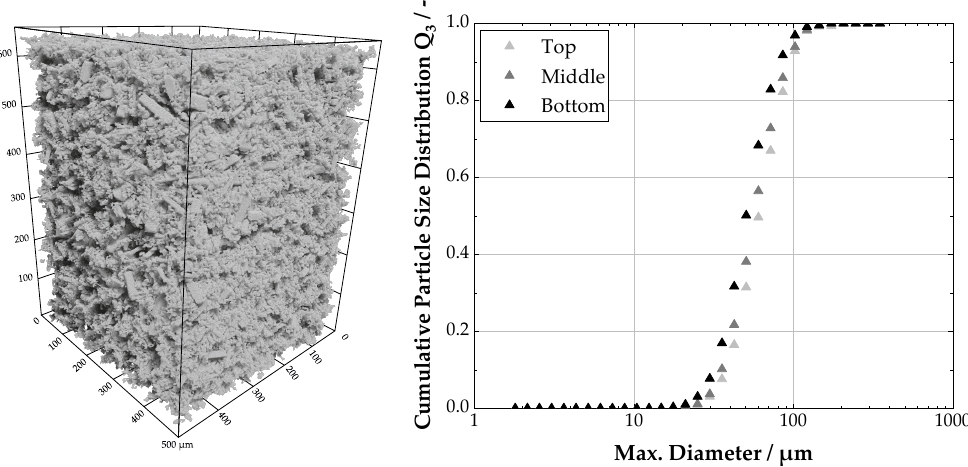
Figure 10. 3D rendering of a filter cake ( left ) and particle size distributions prevailing in the individ- ual layers ( right ). It can be seen that the particle size distribution is almost homogeneous over the entire cake